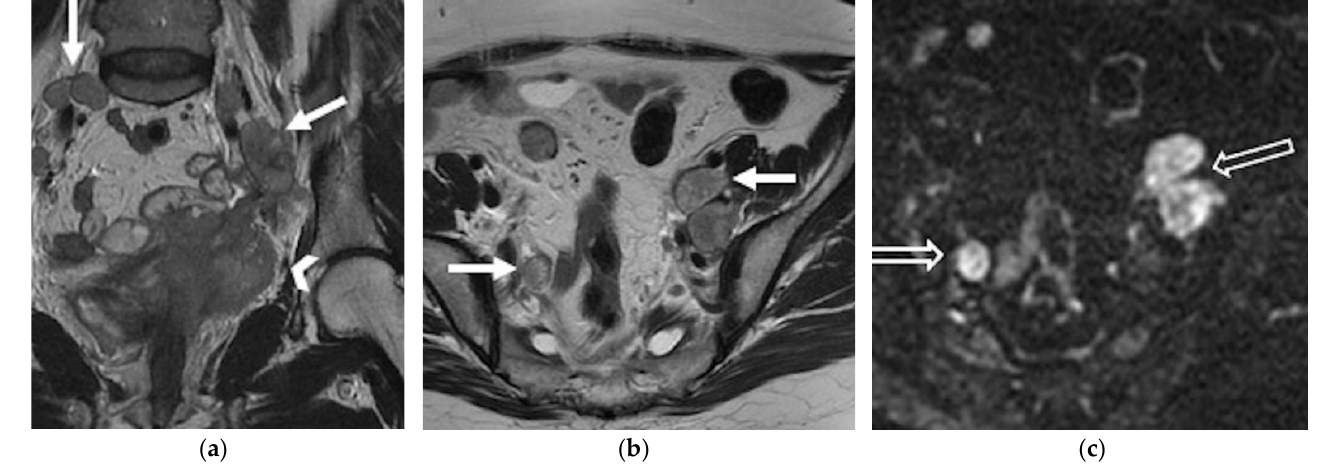
Figure 8. A 55-year-old patient who underwent radical hysterectomy with BSO and chemoradiation therapy for cervical cancer. ( a ) Coronal and ( b ) axial FSE T2-weighted images show multiple pelvic bilateral lymphadenopathies, with heterogenous signal intensity (arrows). Note the recurrent lesion in the vaginal cuff extended to the left parametrium (arrowhead in ( a )). ( c ) The lymphadenopathies demonstrate restriction on diffusion-weighted image (open arrows).